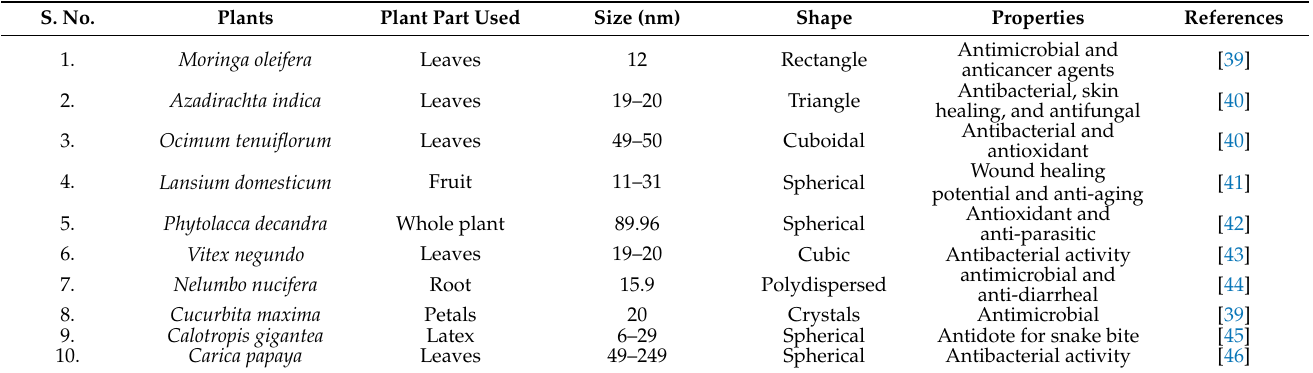
Table 1. Synthesis of green silver nanoparticles using various plant extract and its